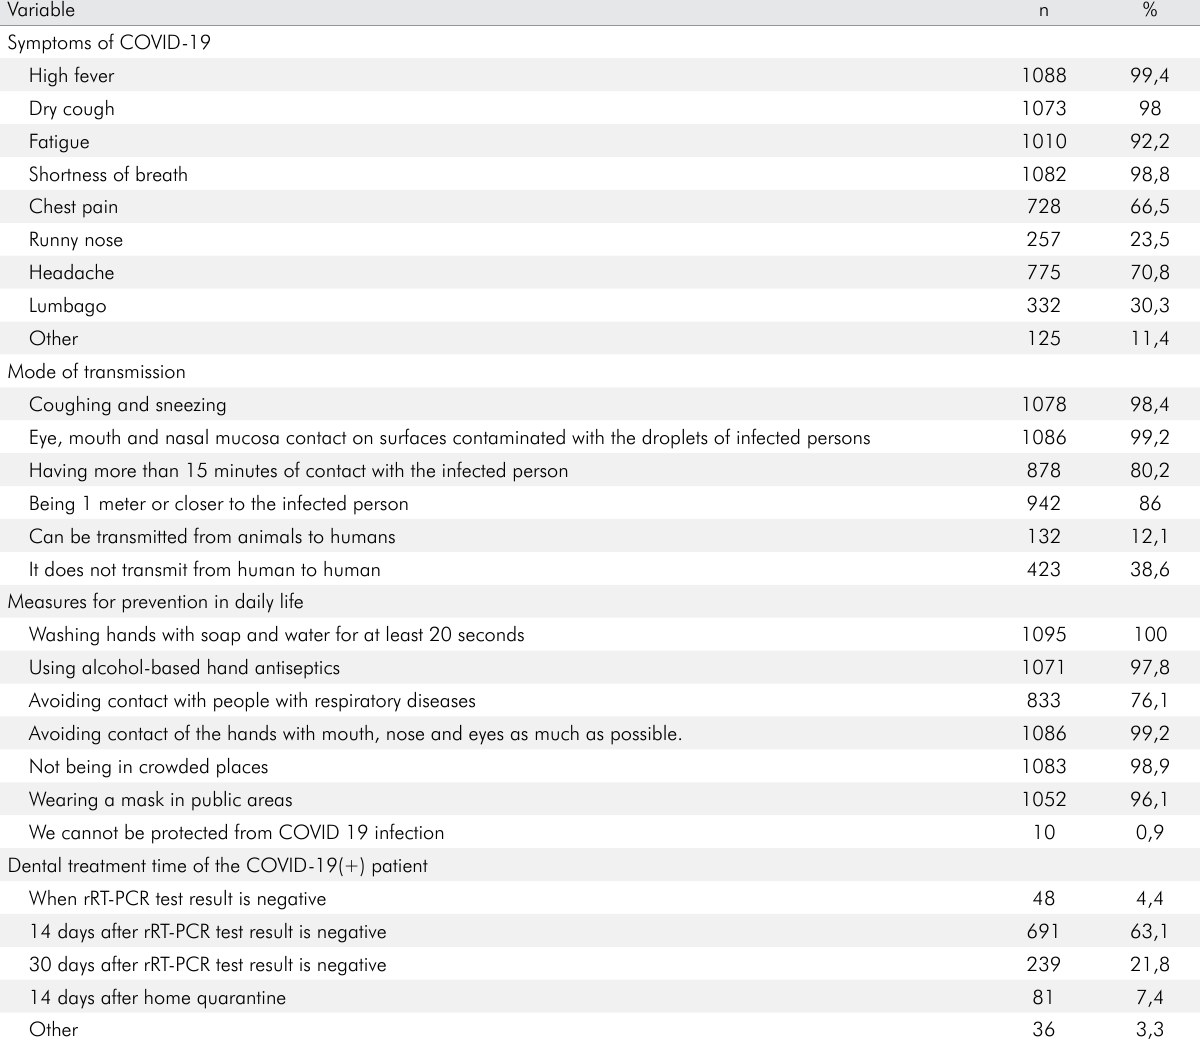
Table 2. Dentists’ awareness about symptoms, mode of transmission, measures for prevention and dental treatment time of the COVID-19 (+)